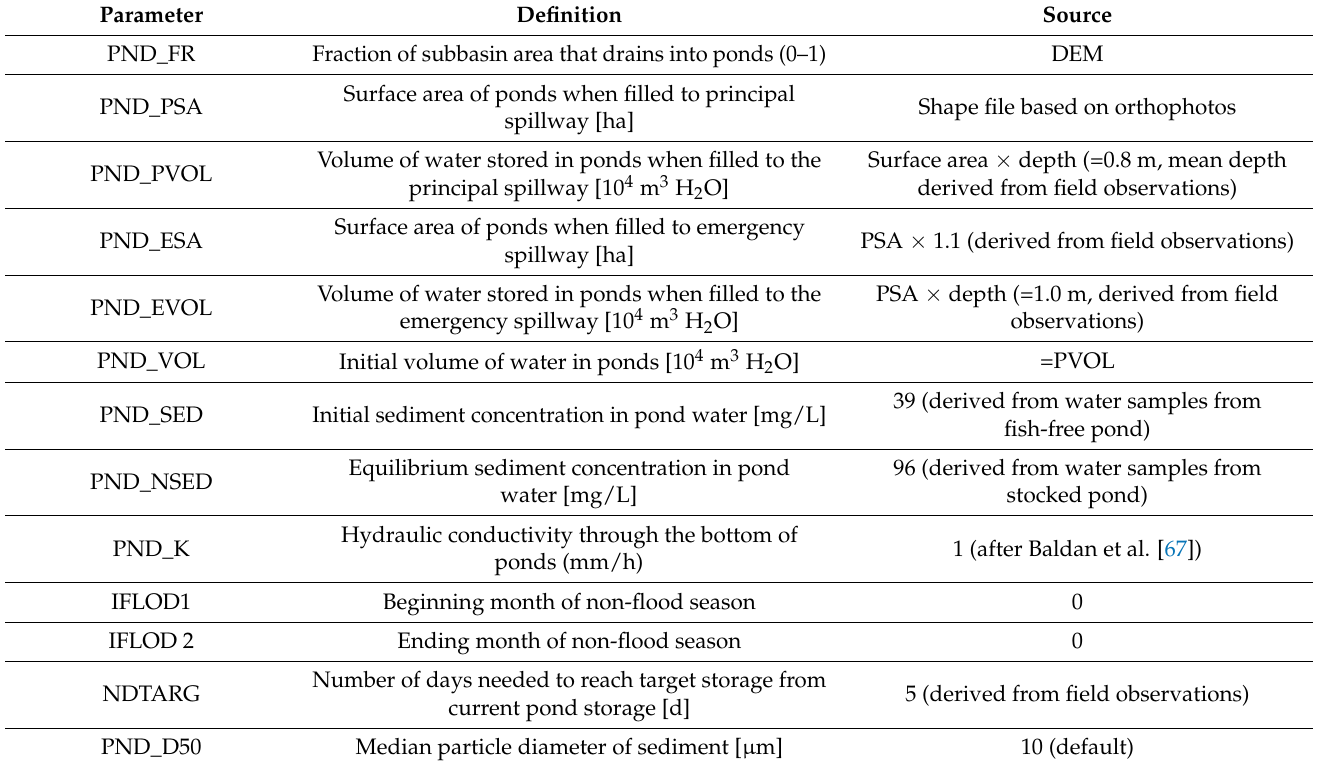
Table 1. Initial input variables used to integrate ponds into the SWAT model: PND-parameters, definition and